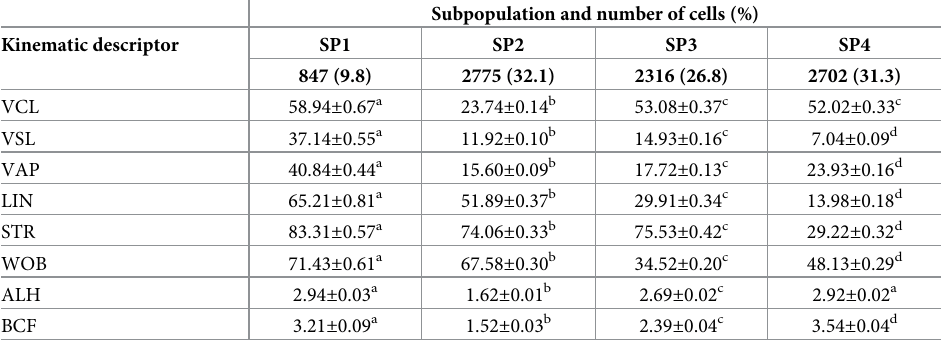
Table 5. Sperm subpopulations (SP) for kinematic variables (means ± SEM) in American crocodile ( Crocodylus acutus ).